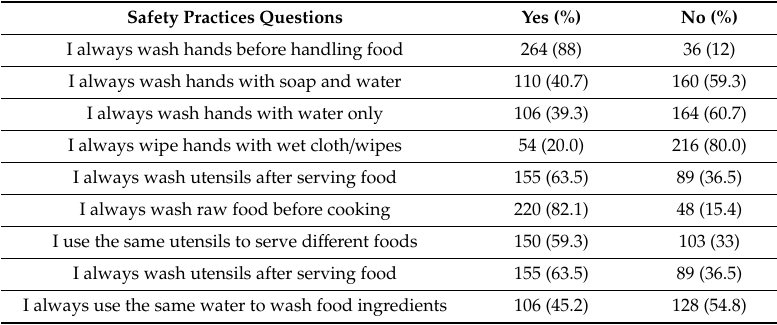
Table 3. Self-reported street food vendors’ food safety